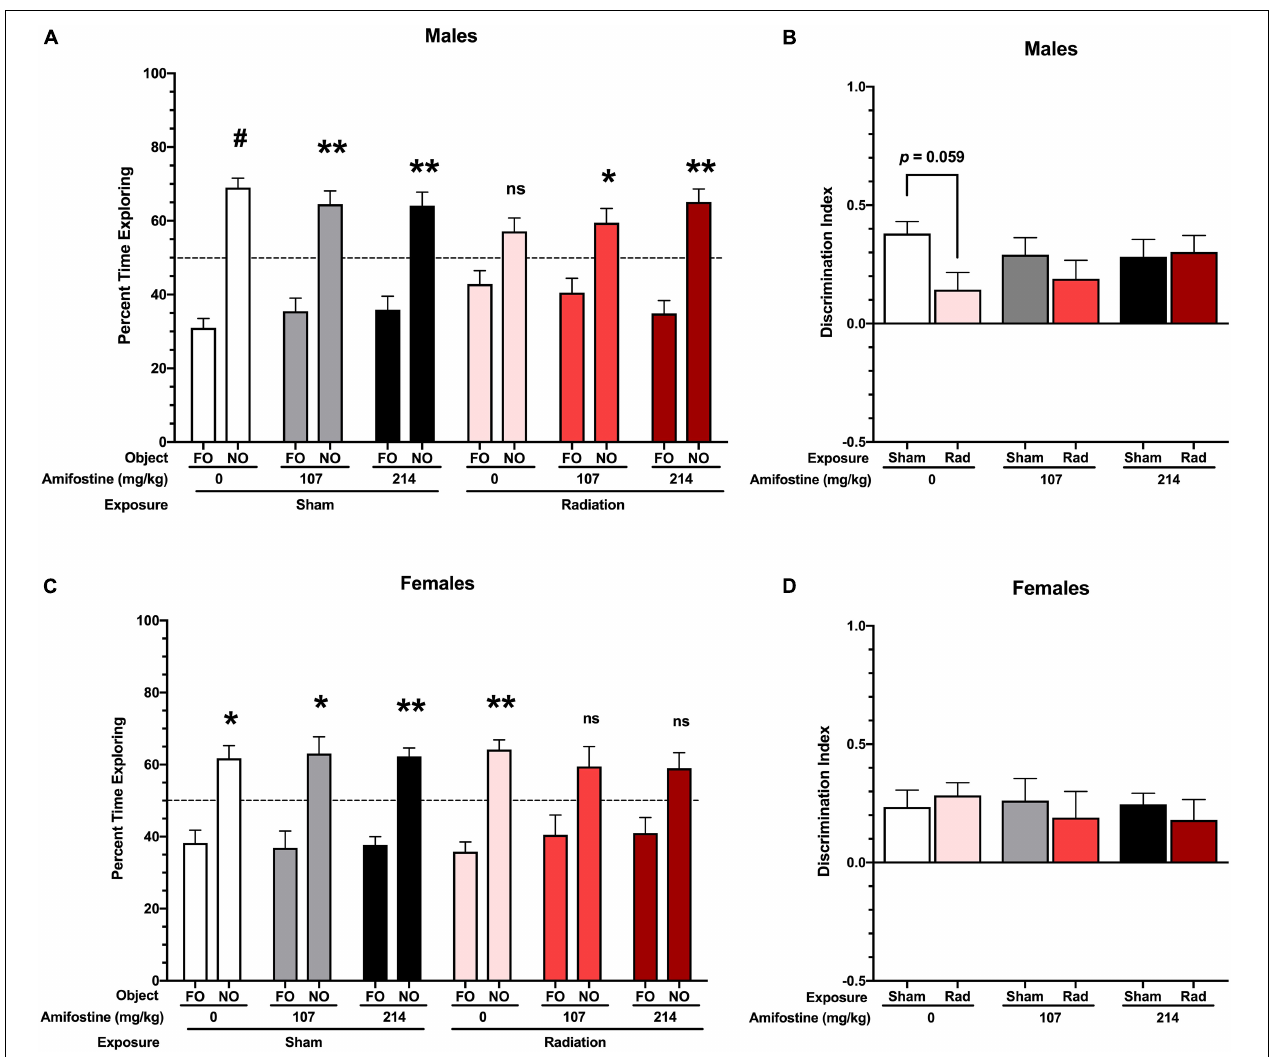
FIGURE 3 | Performance in the novel object recognition test. (A) Percent time spent with the familiar and novel object in male mice. All sham-exposed male mice showed a preference for the novel object (Sham-Saline: p < 0.001; Sham-107 mg/kg: p = 0.007; and Sham-214 mg/kg: p = 0.006). Mice exposed to radiation did not show a preference ( p = 0.09); however, both 107 and 214 mg/kg of amifostine restored preference for the novel object ( p = 0.045 and p = 0.003, respectively). (B) Discrimination index (DI) in male mice. A trend toward a difference based on radiation exposure ( p = 0.071) was found, and Sidak’s post hoc test revealed a trend toward a decrease DI in the Rad-Saline group compared to Sham-Saline ( p = 0.0589). (C) Percent time spent with the familiar and novel object in female mice. All mice in the sham exposure groups showed a preference for the novel object (Sham-Saline: p = 0.021; Sham-107 mg/kg: p = 0.026; and Sham-214 mg/kg: p = 0.001). Female mice exposed to radiation also showed a preference for the novel object ( p = 0.001), but females that received 107 or 214 mg/kg of amifostine prior to radiation did not show a significant preference ( p = 0.137 and p = 0.075, respectively). (D) DI in female mice. No significant differences were detected. Data are presented as means ± SEMs. * p < 0.05; ** p < 0.01; # p <